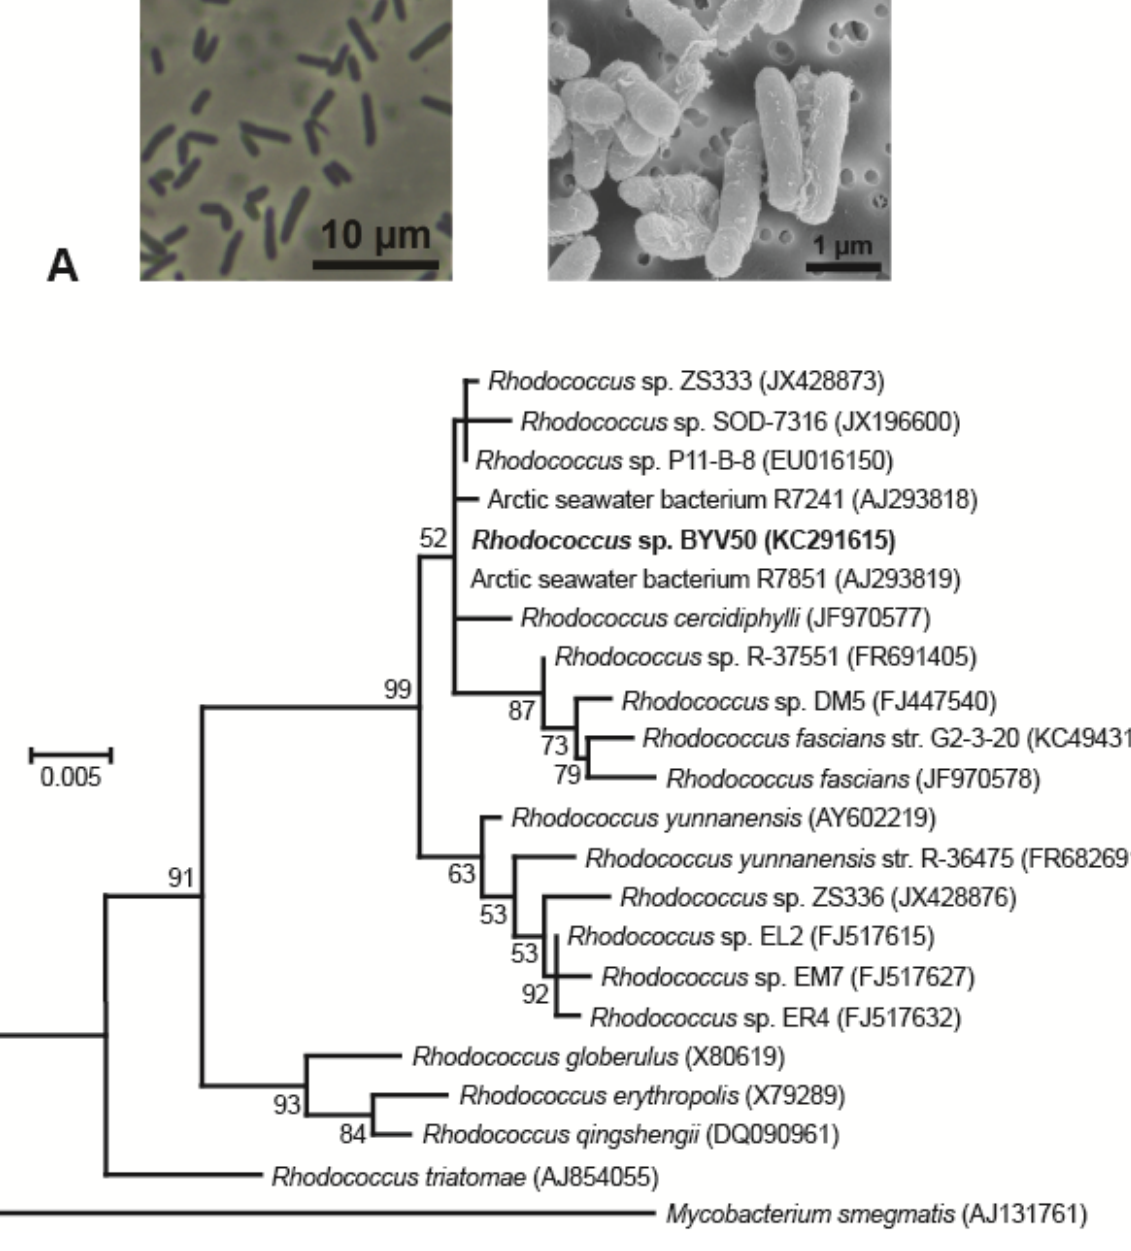
Figure 2. Morphology and phylogeny of Rhodococcus strain BYV50. ( A ) Phase-contrast micrograph (left) and scanning electron micrograph (right) showing cell morphology and arrangement; ( B ) Phylogenetic tree generated from 1435 nucleotide positions of the 16S rRNA gene. Mycobacterium smegmatis is the outgroup organism, and bootstrap values >50% are shown at the branching points. GenBank accession numbers are listed in